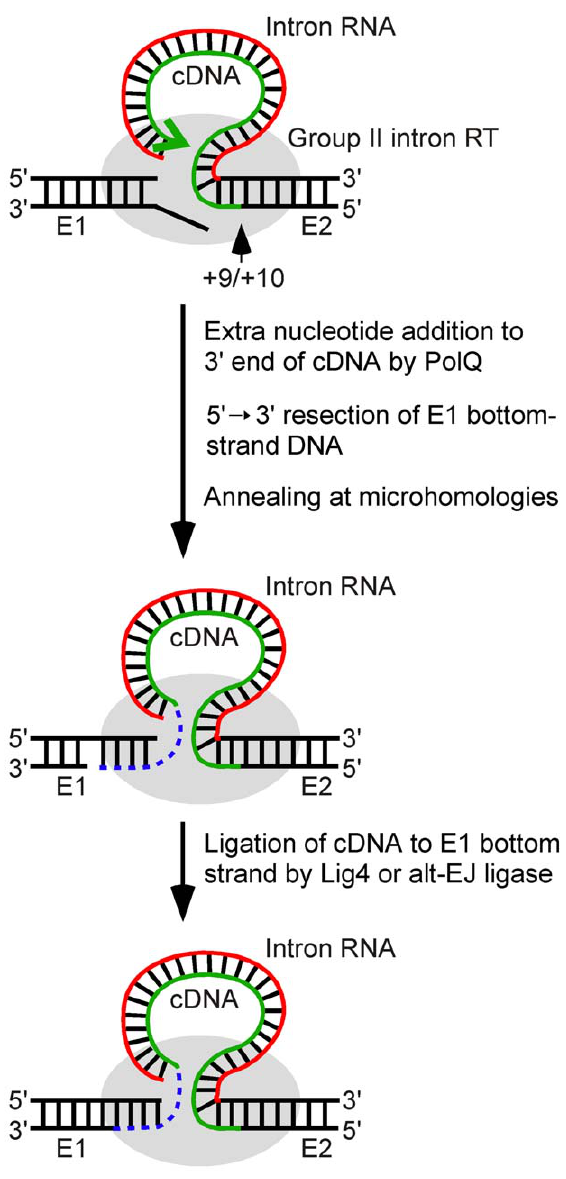
Figure 8. Model for ligation of the intron cDNA to exon 1 during linear group II intron retrohoming. Partial reverse splicing of the linear intron RNA into the DNA target site is followed by bottom- strand cleavage between E2 positions + 9 and + 10 and synthesis of a cDNA of the attached linear intron RNA. After cDNA synthesis reaches the 5 9 end of the intron RNA template, extra nucleotide residues are added to the 3 9 end of the cDNA generating microhomologies that enable annealing of the cDNA strand to the top strand of E1. In Drosophila , the repair DNA polymerase h is the major enzyme responsible for this extra nucleotide addition, but some extra nucleotide addition may also be done by other host DNA polymerases or by the Ll.LtrB RT. The annealing of the cDNA requires unwinding and/or resection of the bottom strand, leading to loss of the bottom- strand 5 9 overhang resulting from the initial double-strand break by the group II intron RNP. In the final step, the annealed cDNA is ligated to the bottom strand of E1 by DNA ligase 4 or an alternate ligase. The retrohoming of the linear intron RNA is completed by degradation or displacement of the intron RNA template strand, second-strand DNA synthesis, and sealing of nicks by host enzymes. E1 and E2, 5 9 and 3 9 exons,